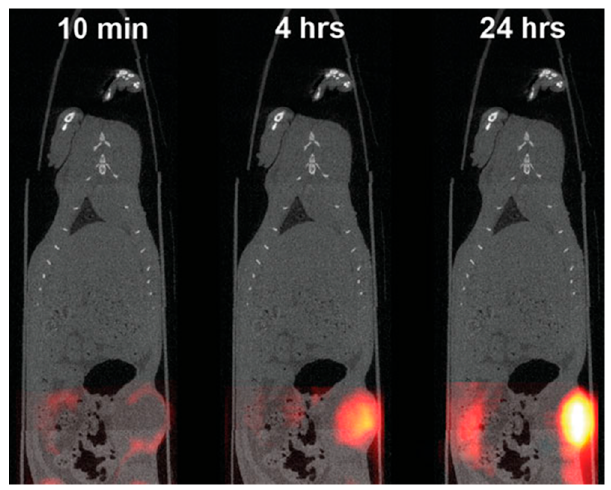
Figure 4. In vivo MPI/CT image of a human breast tumor in a murine model, using SPIO nanoparticles specifically designed for MPI [94]. SPIO nanoparticles can be observed to accumulate in tumor having a contrast peak at 24 h post injection. Adapted from Zheng et al. [78]. a contrast peak at 24 h post injection. Adapted from Zheng et al.